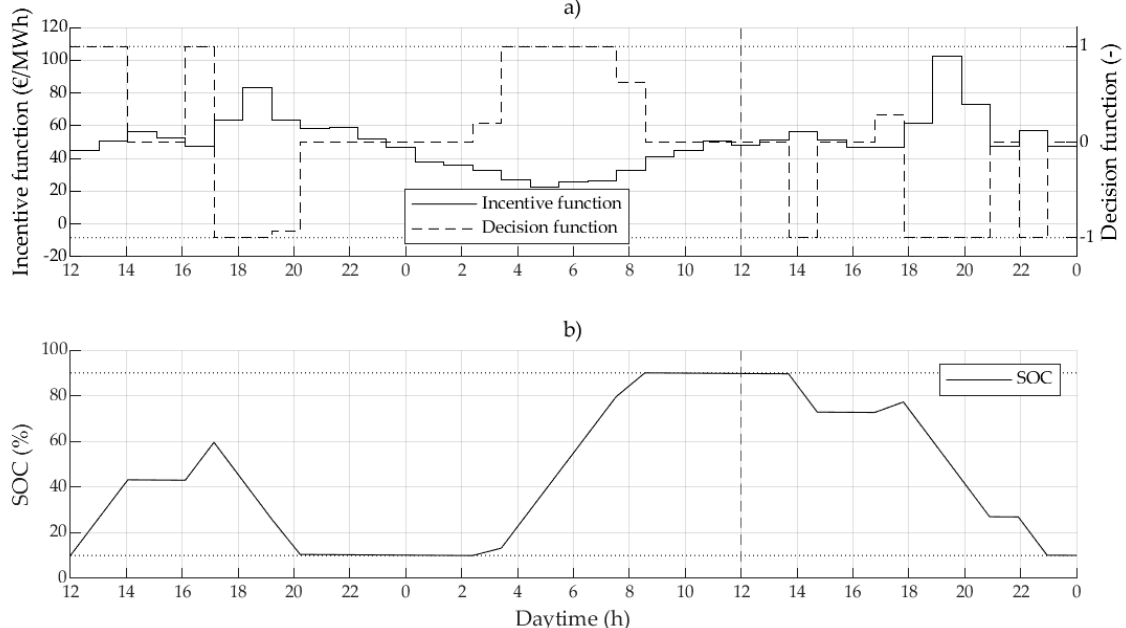
Figure 2. Exemplary day-ahead stock market price-based battery operation for 36 h. The battery operation is calculated for the day-ahead price for the United Kingdom, starting at noon on 1 January 2015 until midnight on 2 January 2015: ( a ) day-ahead price (incentive function) and resulting decision function, ( b ) corresponding battery state of charge.